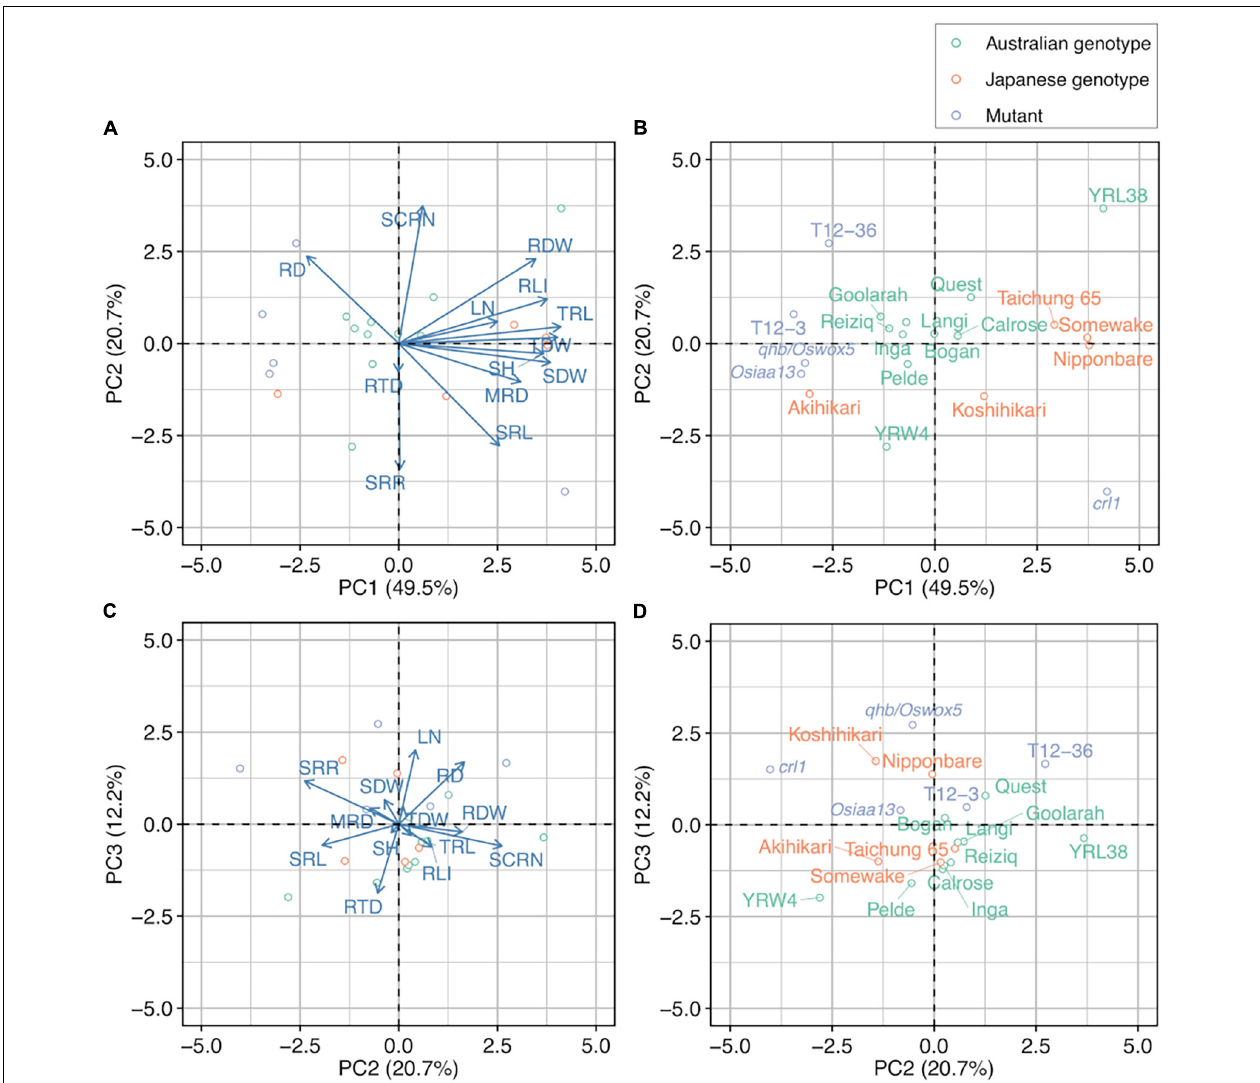
FIGURE 2 | Principal component analysis of 13 selected major traits in 20 rice genotypes grown in a semihydroponic phenotyping system for 55 days after transplanting. Biplot for (A) PC1 and PC2 and (C) PC2 and PC3. Corresponding distribution of 20 rice genotypes for (B) PC1 and PC2 and (D) PC2 and PC3.